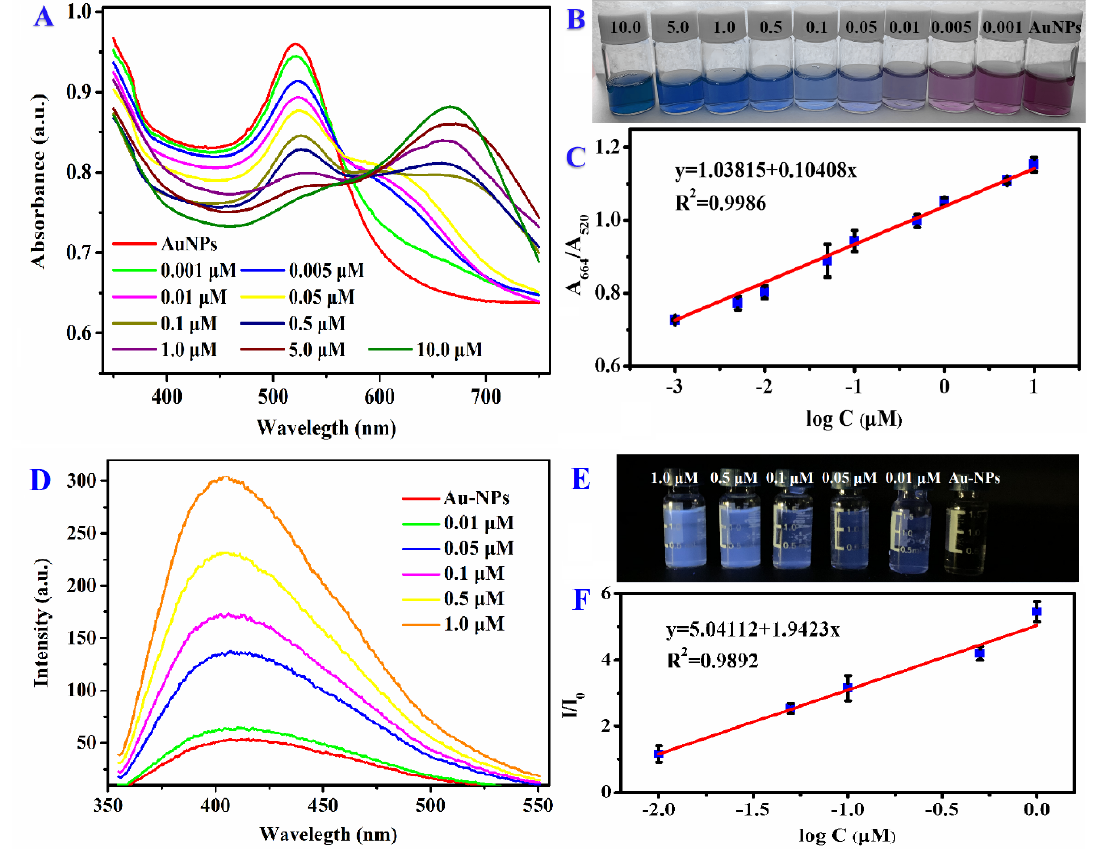
Figure 3. ( A ) UV–vis and ( D ) fluorescence spectra of Au-NPs with various concentrations of histamine. The corresponding ( B ) colorimetric and ( E ) fluorescent response of histamine-Au-NPs under daylight and 365nm UV-light. Linear relationships between ( C ) the absorption ratios (A 664 /A 520 ), ( F ) the fluorescence intensity ratios (I/I 0 ), and the logarithm value of histamine concentrations.